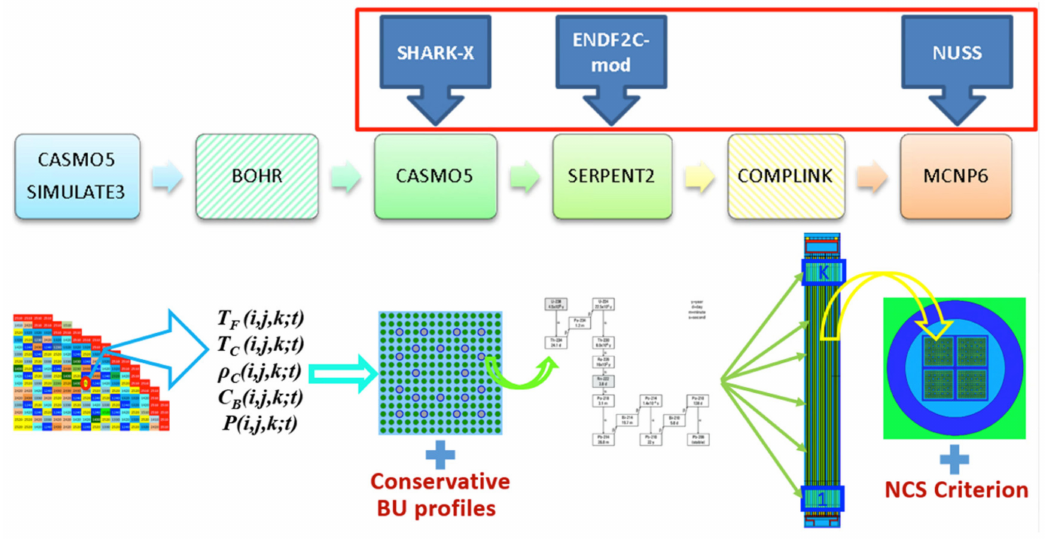
Figure 2. Schematic view of the Burnup Credit System for the Swiss Reactors–Repository (BUCSS-R) methodology and nuclear data perturbation tools (red frame)